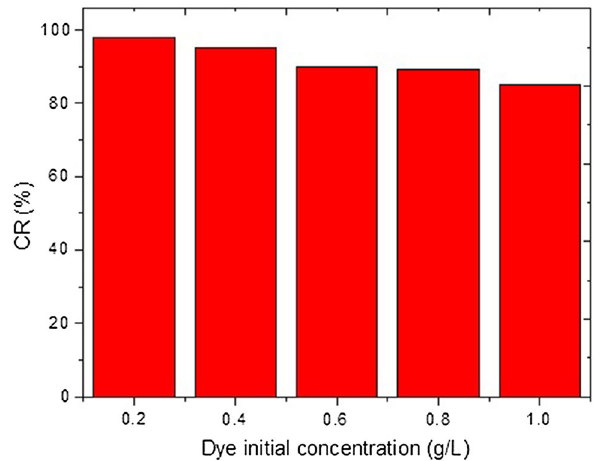
Fig. 5 Effect of the initial concentration of the dye on the removal efficiency of Eriochrome Black. [NaCl] = 1.0 g L −1 ; electrolysis time = 120 min; pH 7.0; and E = 7.0 V